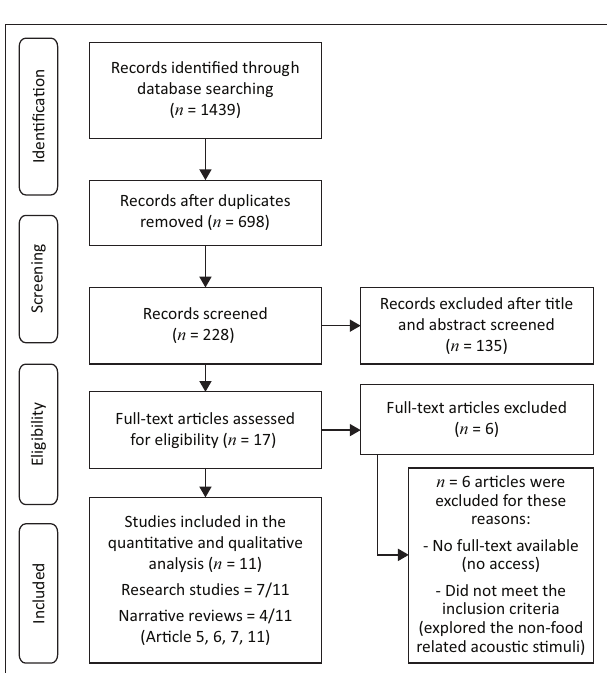
FIGURE 1-A3: Preferred Reporting Items for Systematic Reviews and Meta- analyses extension for Scoping Review (PRISMA-ScR) flow diagram results.